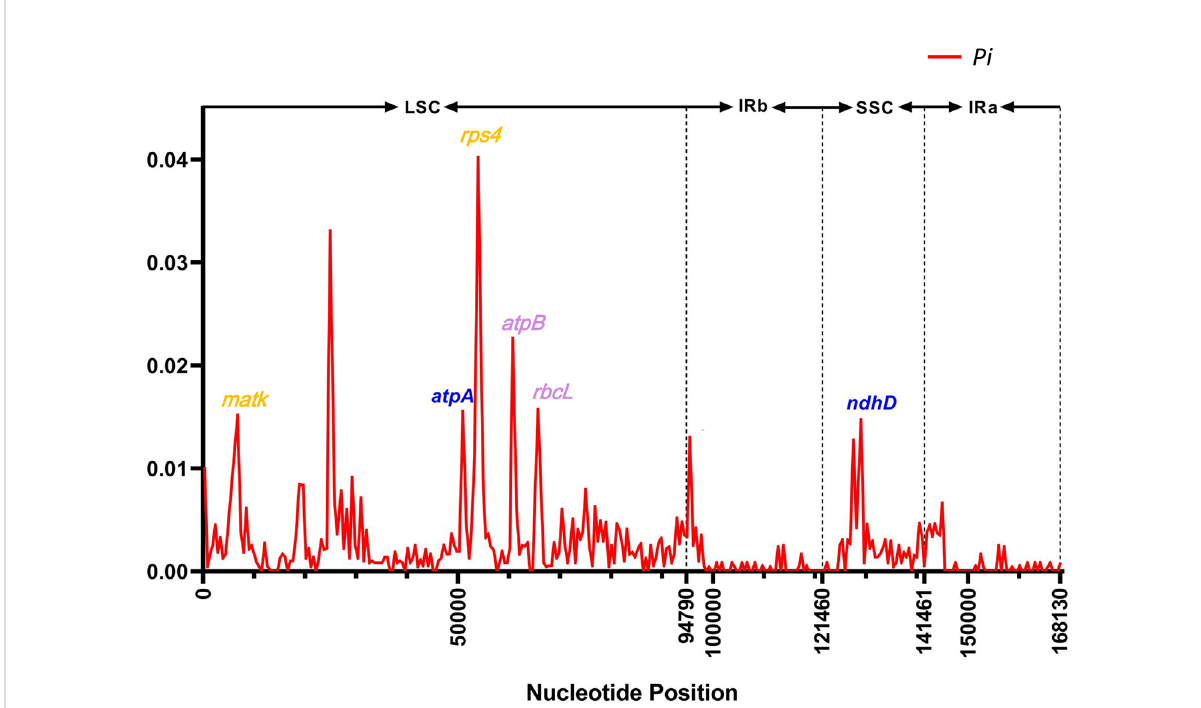
FIGURE 6 The Pi value in sliding-window analysis of the whole chloroplast genomes. The genes highlighted in blue color showcase the SNPs between K. candel and K. obovata . The genes highlighted in orange color were SNPs within K. candel species. The purple color highlighted genes were SNPs within K. obovata